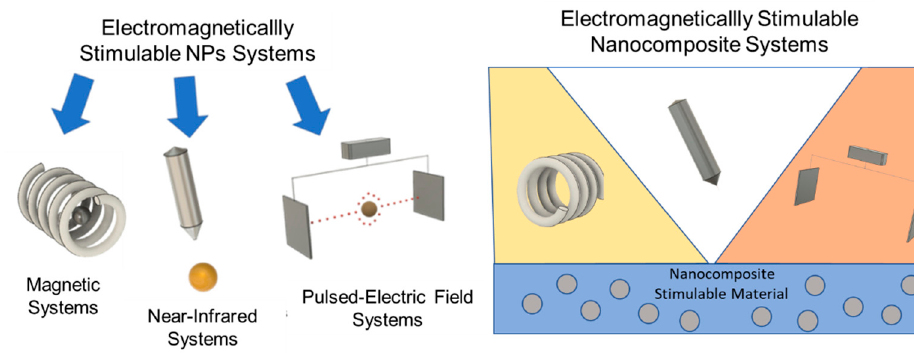
Figure 5. Electromagnetically stimulable systems. Table 1. Table of the contents.